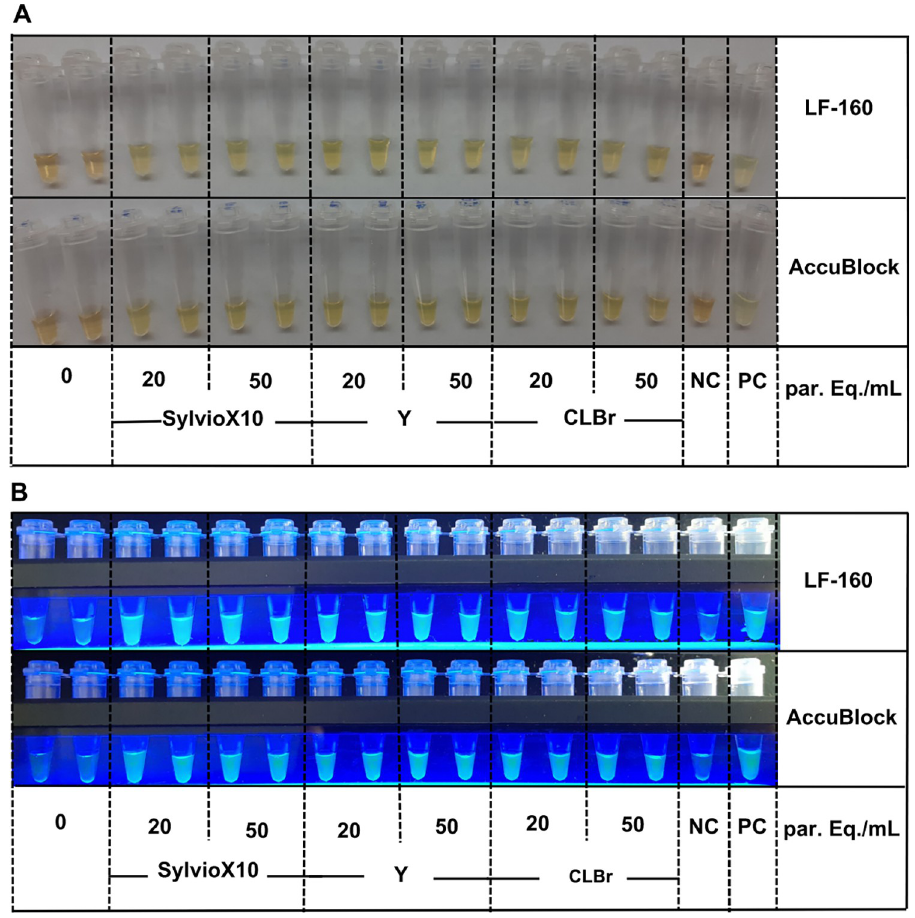
Fig 3. Inclusivity and reproducibility of LAMP using FTA cards seeded with three different T . cruzi strains in two different incubators and different ways of visualization. (A) LAMP results obtained after incubation in LF-160 or AccuBlock and naked eye visualization. (B) LAMP results obtained after incubation in LF-160 or AccuBlock and visualization using the LF160 visualizer. Parasitic loads per mL of blood are indicated at the bottom of the Figures. NC: negative control; PC: positive